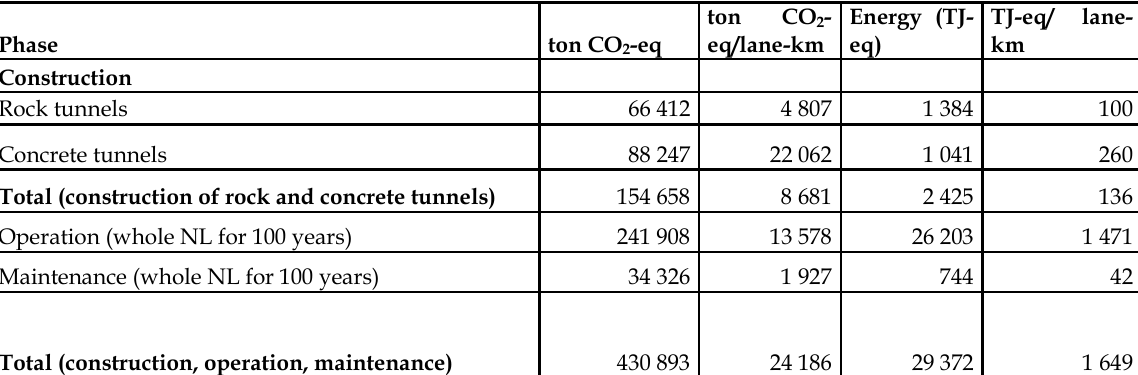
Table 4. Cumulative Energy Demand and Global Warming Potential during the life cycle of the entire Norra Länken (including rock and concrete parts)